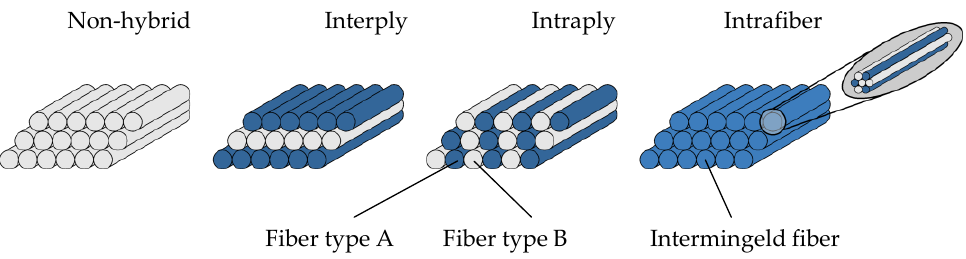
Figure 1. Hybridization types of composites in comparison.